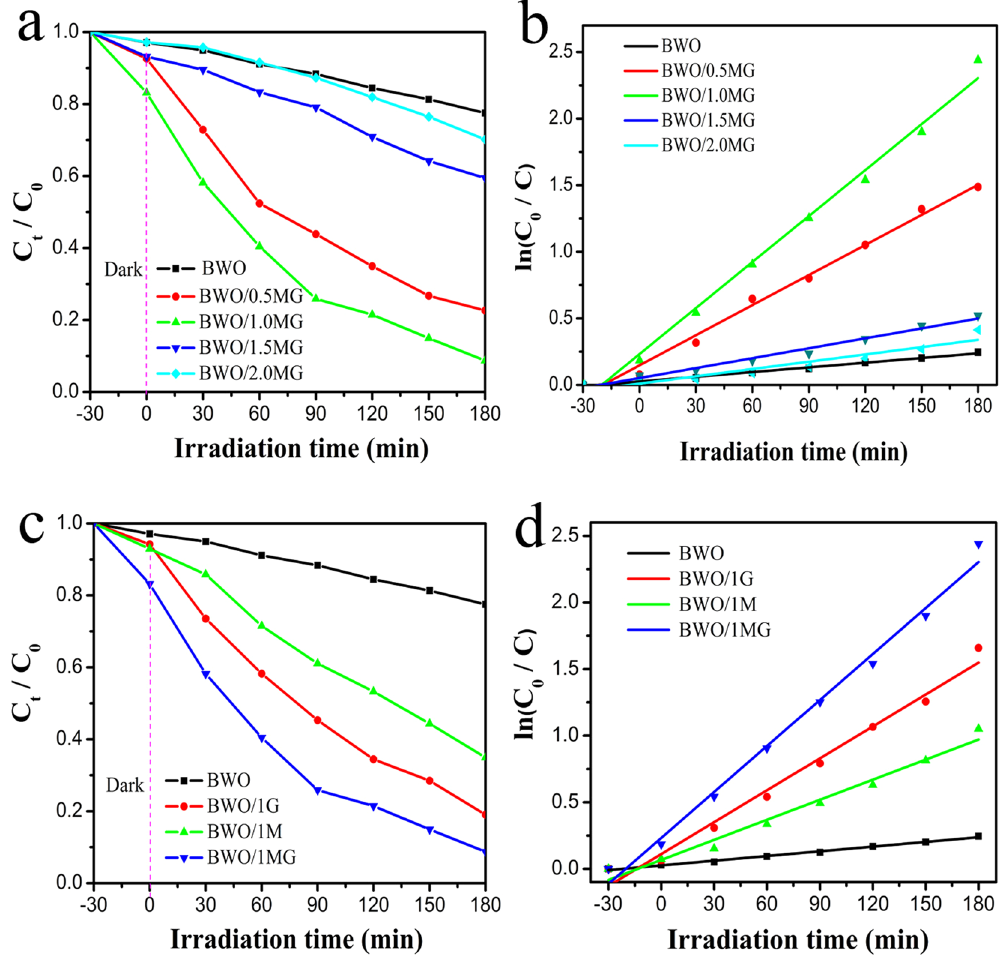
Figure 4. Photocatalytic degradation of RhB over ( c ) BWO, BWO/1 G, BWO/1 M and ( a ) different mass ratio of BWO/MG composites under visible light irradiation ( λ > 400 nm). ( a , c ) The photodegradation plots and ( b , d ) the apparent reaction rate constants k for the photodegradation of RhB. ( c ) the composite photocatalysts containing 1% graphene, MoS 2 and MG,